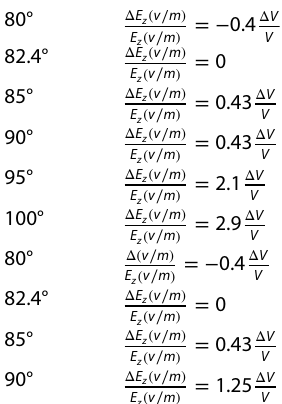
Fig. 11 Test results of pulse-to-pulse stability for pulse modulator. Running standard deviation of the amplitude of 632 consequent pulses measured simultaneously by oscilloscope Table 1 calculated result of Phase point Calculated different phase point